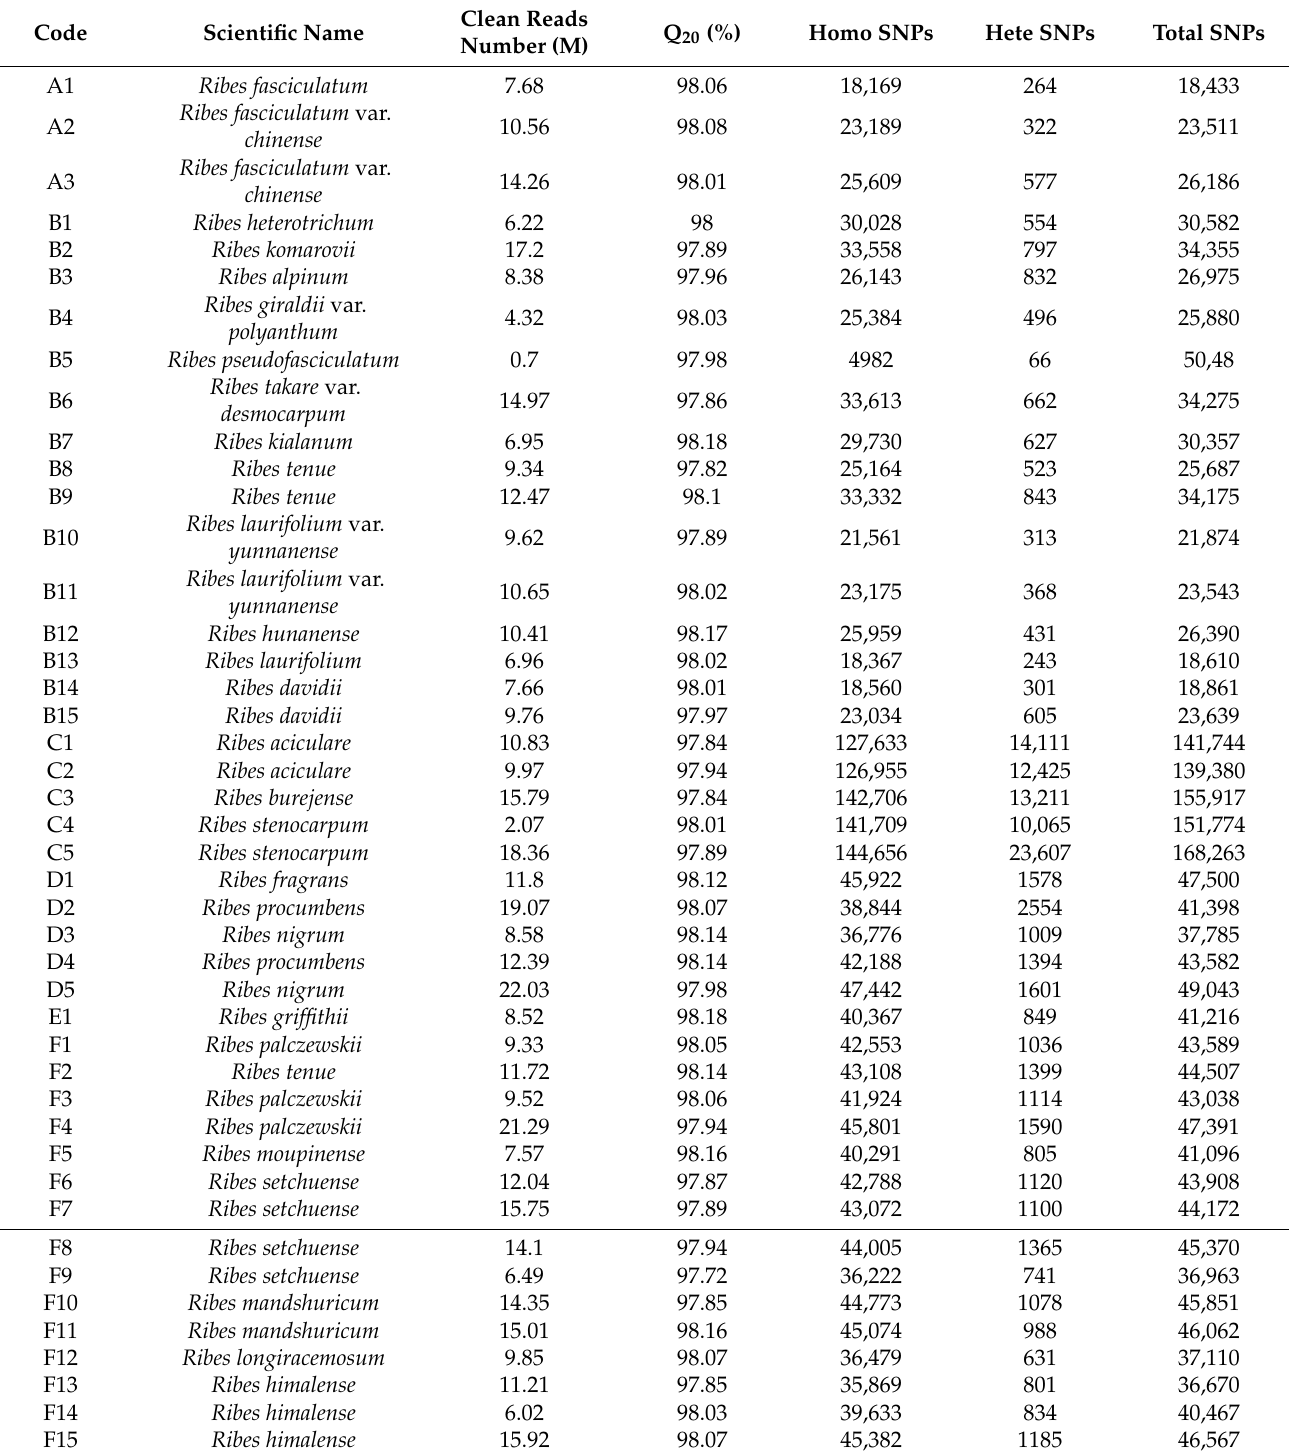
Table 1. The clean reads number, Q 20 , homo SNPs, hete SNPs, and total SNPs for Ribes L. samples were measured by RAD-seq and their corresponding code, scientific